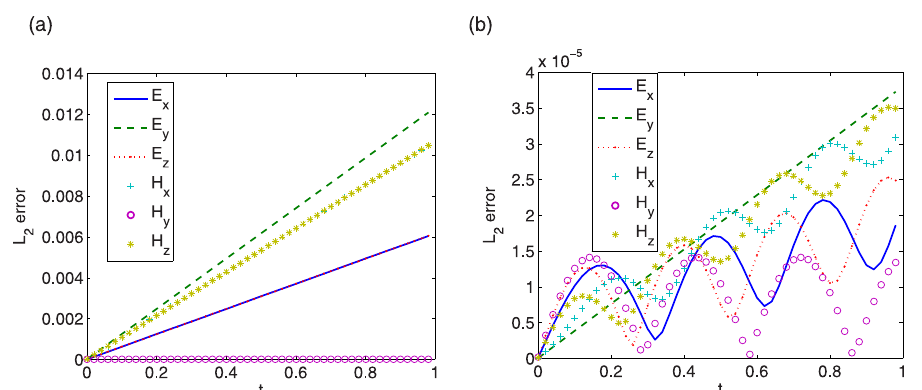
Fig 11. L 2 errors of numerical solutions to LOD central box scheme (left) and LODEFMS scheme (right) in first testing case.